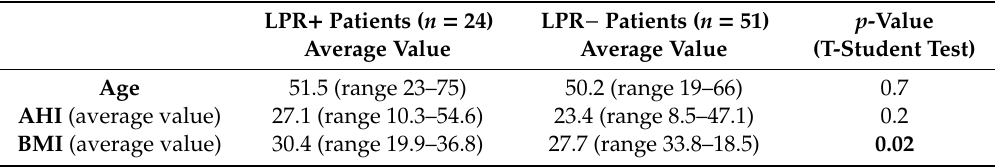
Table 1. Di ff erences between LPR + and LPR − patients regarding age, AHI, and BMI. Diagnosis of LPR performed using salivary pepsin